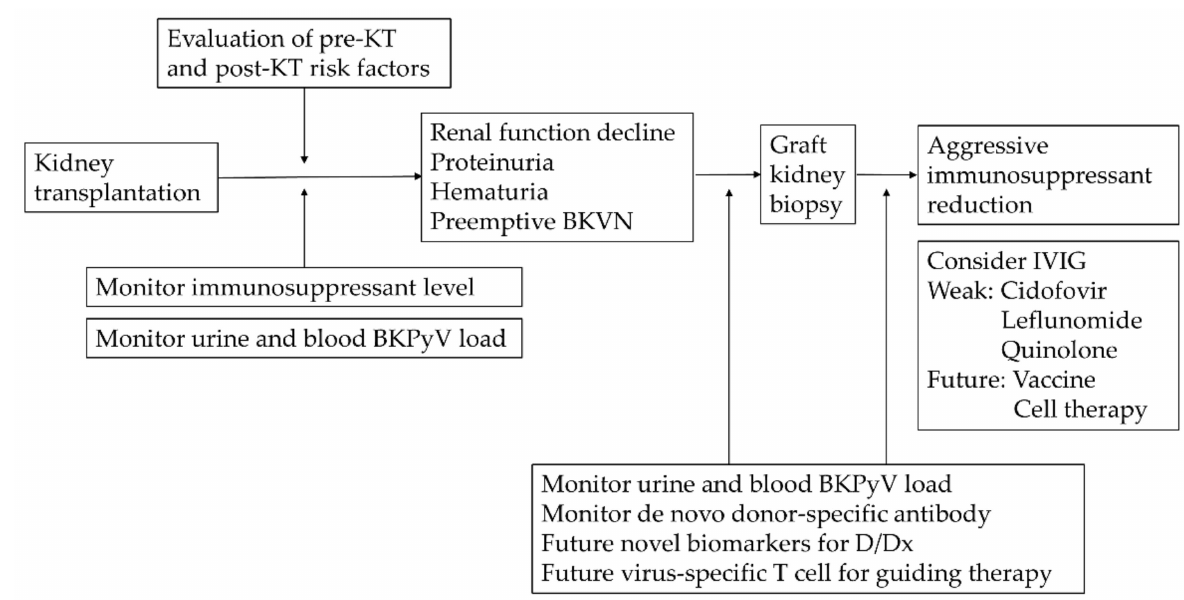
Figure 3. Conceptual illustration of evaluations, screening, diagnosis, and management for BKPyV infection. Abbre- viations: KT, kidney transplant; BKPyV, BK polyomavirus; BKVN, BK polyomavirus nephropathy; IVIG, intravenous immunoglobulin; D/Dx, differential